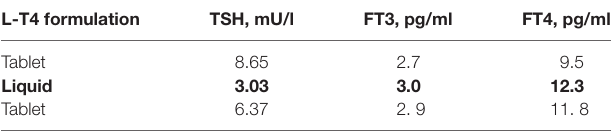
taBLe 1 | Thyroid parameters measured when patient no. 2 was receiving oral levothyroxine (L-T4) in the tablet formulation, after 2 months of L-T4 in the liquid formulation (in bold), and then after 1 month of return to the tablet formulation.